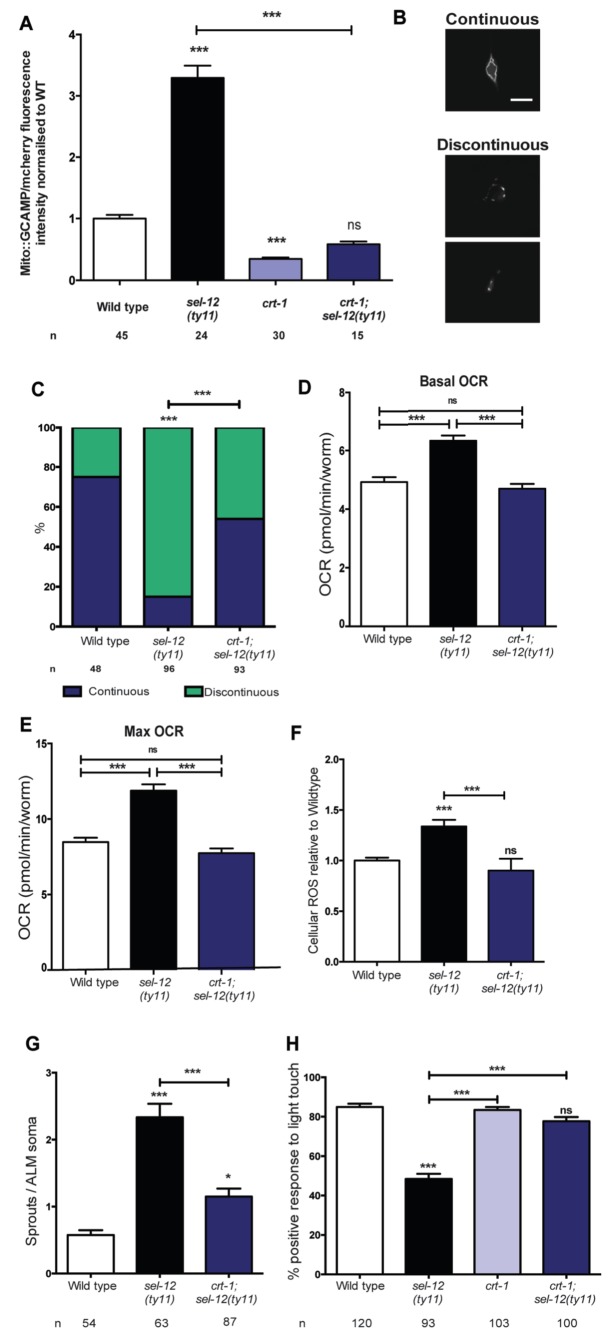
Reducing ER Ca2+release in sel-12 mutants rescues mitochondrial disorganization and dysfunction, ectopic neurite sprouting and mechanosensory defects.(A) Quantification of mitochondrial Ca2+ using animals expressing mito::GCaMP6 and mCherry in their body wall muscle (takEx347). n = 30 per strain. (B) Representative images and (C) quantification of ALM neuronal mitochondrial morphology. Scale bar represents 10 μm. Analysis was done using transgenic animals expressing mito::GFP in mechanosensory neurons (jsIs609). Data are displayed with blue and green representing the percentage of animals displaying continuous and discontinuous mitochondrial morphology, respectively. ***p<0.001 (Chi-square test). (D) Basal and (E) maximal respiration rates (after exposure to FCCP) of wild type, sel-12(ty11), and crt-1;sel-12(ty11) animals. Data are from three replicate assays. (F) H2DCF-DA assay measuring ROS levels relative to wild type. Data are from three replicate assays. (G) Quantification of aberrant neuronal structures (sprouts/branches) in ALM neurons in day one animals. ALM neuronal morphology analysis is done using transgenic animals expressing mec-4p::GFP (zdIs5). (H) Quantification of the response of day one adult animals to light anterior and posterior touch. n = number of animals analyzed per genotype. Data are displayed as mean ± SEM, and all comparisons have been made to wild type animals unless otherwise indicated. ns p>0.05, *p<0.05, ***p<0.0001 (One way ANOVA with Tukey test).10.7554/eLife.33052.024Figure 6—source data 1.Raw data for Figure 6.